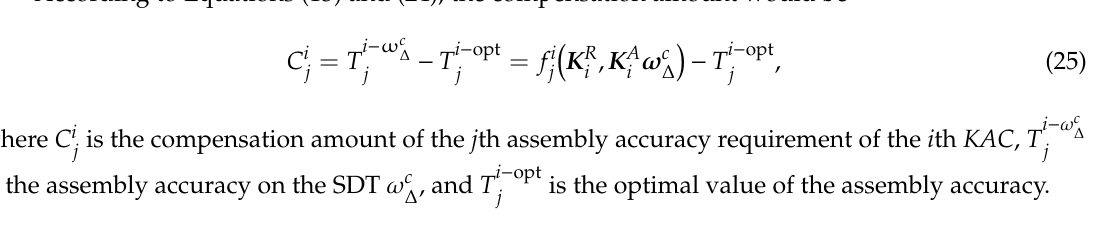
Figure 9. Space manipulator assembly.